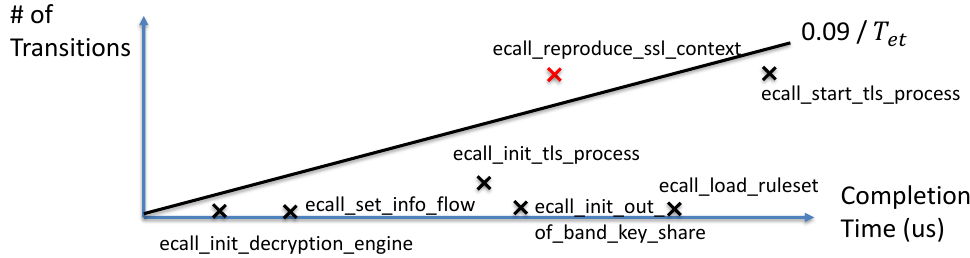
Figure 4. Switchless efficiency of each ECALL used by